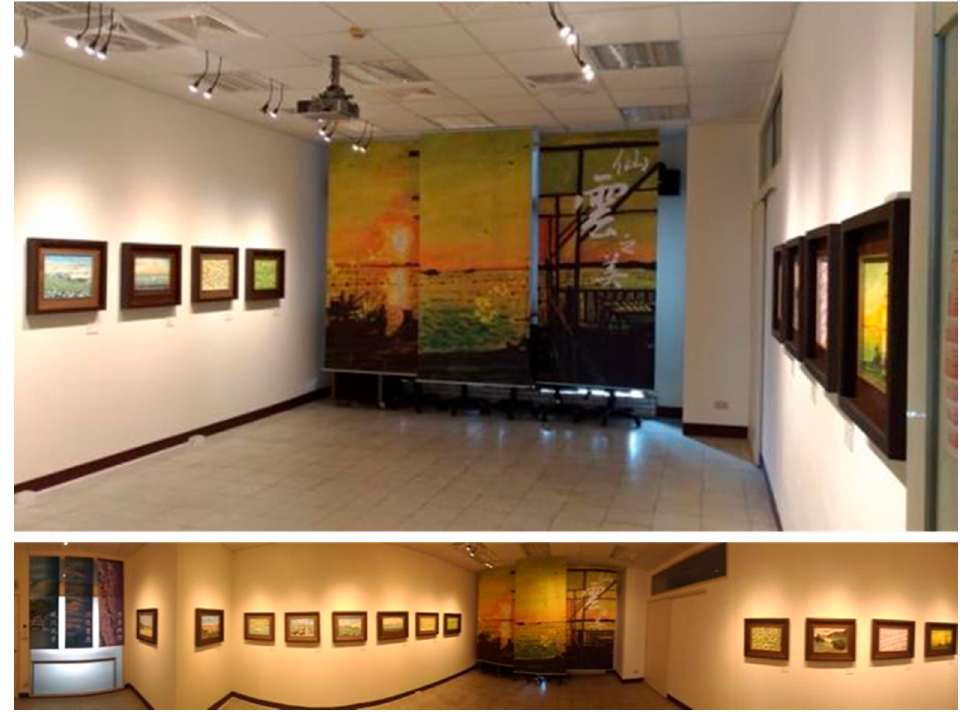
Figure 2. Exhibition of physical original works. The photo on top is the decoration of auxiliary visual hanging scrolls and the photo on bottom is the 360 ° panoramic scene.